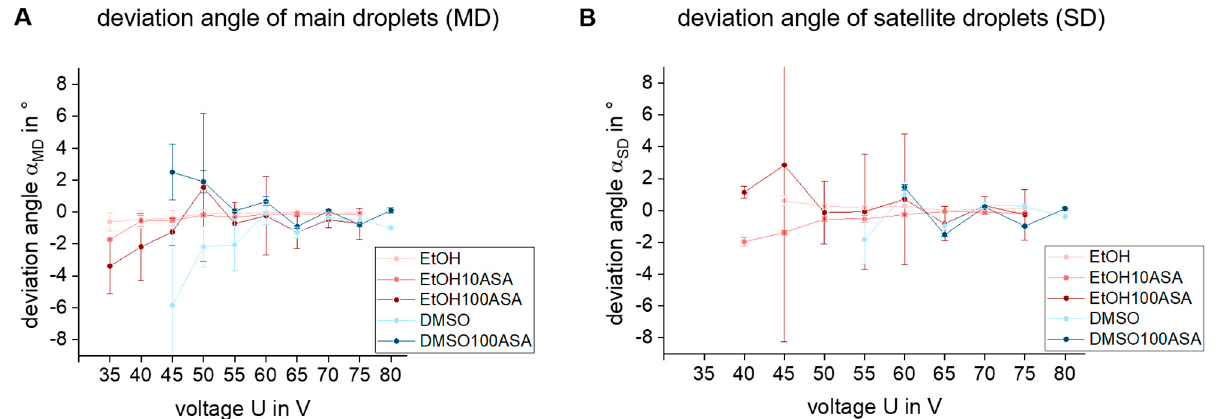
Figure 3. Plots of deviation angle of main droplets ( α MD , ( A )) and satellite droplets ( α SD , ( B )) over voltage of the printhead for EtOH-based drug solutions as well as the pure solvents. The deviation angle of a main droplet ( α MD ) was measured with regard to a vertical line from the nozzle, the deviation angle of a satellite droplet α SD was measured with regard to the trajectory of the associated main droplet. There are relatively high standard deviations for EtOH100ASA over the whole voltage range. Therefore, there is low reproducibility of a droplet’s trajectory. The plots show means ± standard deviations for n = 10.